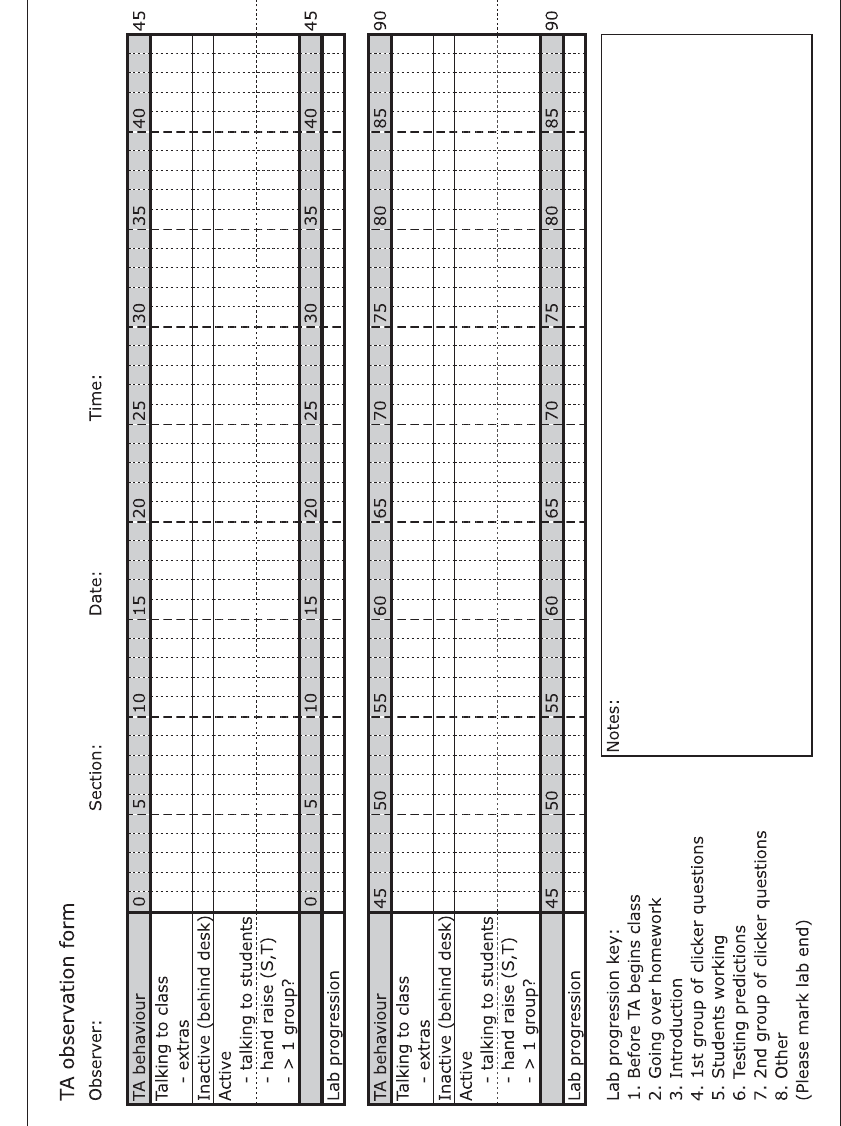
FIG. 7. The TA observation form. To complete the form, the observer shades in the areas of the timeline corresponding to the TA ’ s actions during the lab, giving a record of the TA ’ s behaviors during the